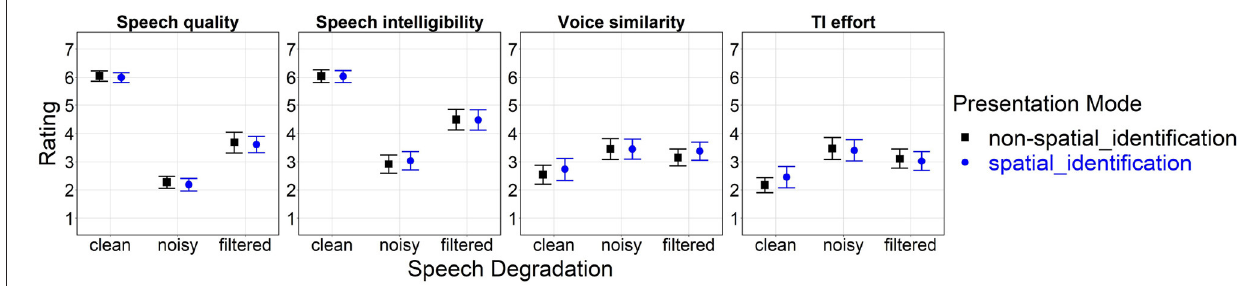
FIGURE 3 | Effects of presentation mode and speech degradation on rating for evaluative (speech quality, speech intelligibility) and task-related [voice similarity, talker-identification (TI) effort] attributes of overall listening experience. The numeric range of the y-axis (1–7) corresponds to scale labels shown in Figure 2 . Error bars represent 95% confidence intervals. Another version of this figure originally appeared in Uhrig et al. (2020a), copyright 2020, with permission from